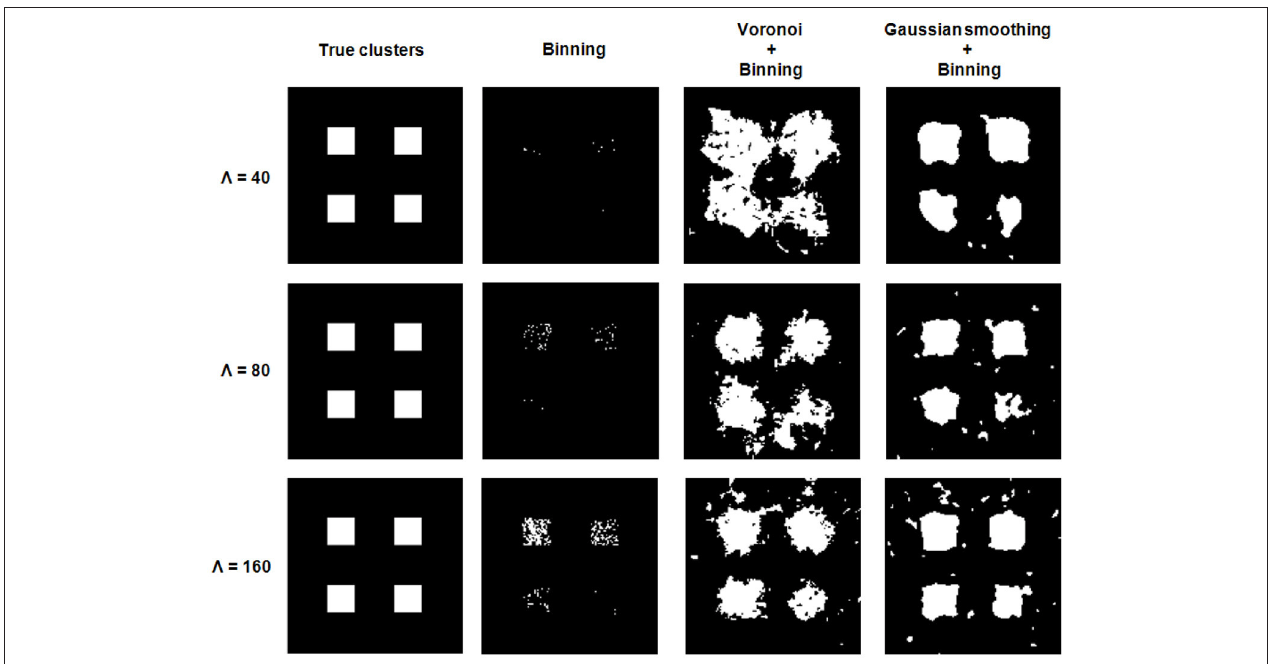
FIGURE 4 | Cluster detection for the three simulation experiments. Each experiment consists of 10 images from the control group and 10 images from the exarcerbated group. From left to right: Location of the true clusters, clusters detected via binning alone, Voronoi tesselation combined with binning and Gaussian smoothing combined with binning.